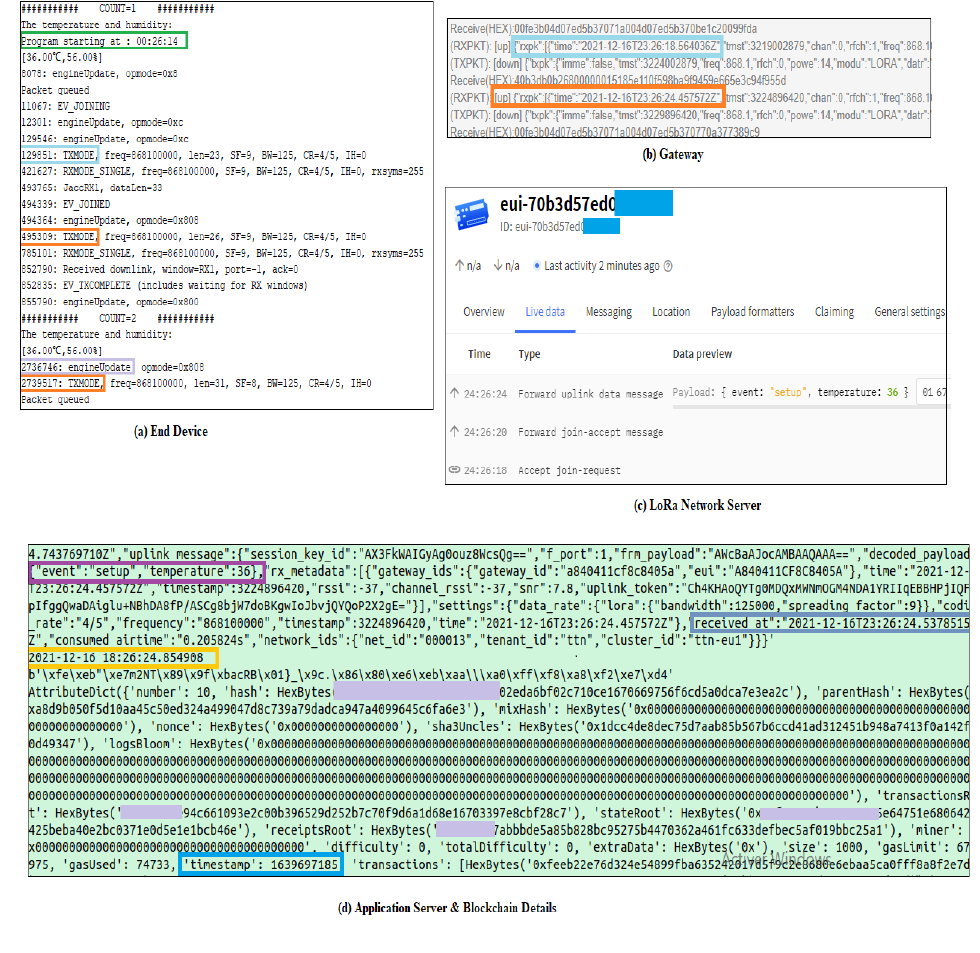
Figure 6. Transmission Time